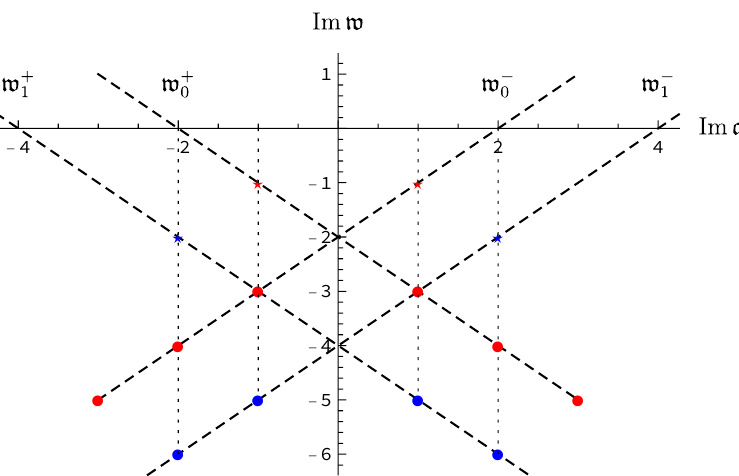
Figure 15 . Pole-skipping and level-crossing points in a 2 d CFT correlator of operators with conformal dimension (cid:1) = 2, for the smallest in magnitude poles w (cid:6) and w (cid:6) . The red stars at 0 1 Im q = (cid:6) 1 correspond to the pole-skipping points and the red dots label the critical points of level- crossings of w (cid:6) . The blue stars at Im q = (cid:6) 2 correspond to the pole-skipping points and the blue 0 dots label the critical points of level-crossings of w (cid:6) 1